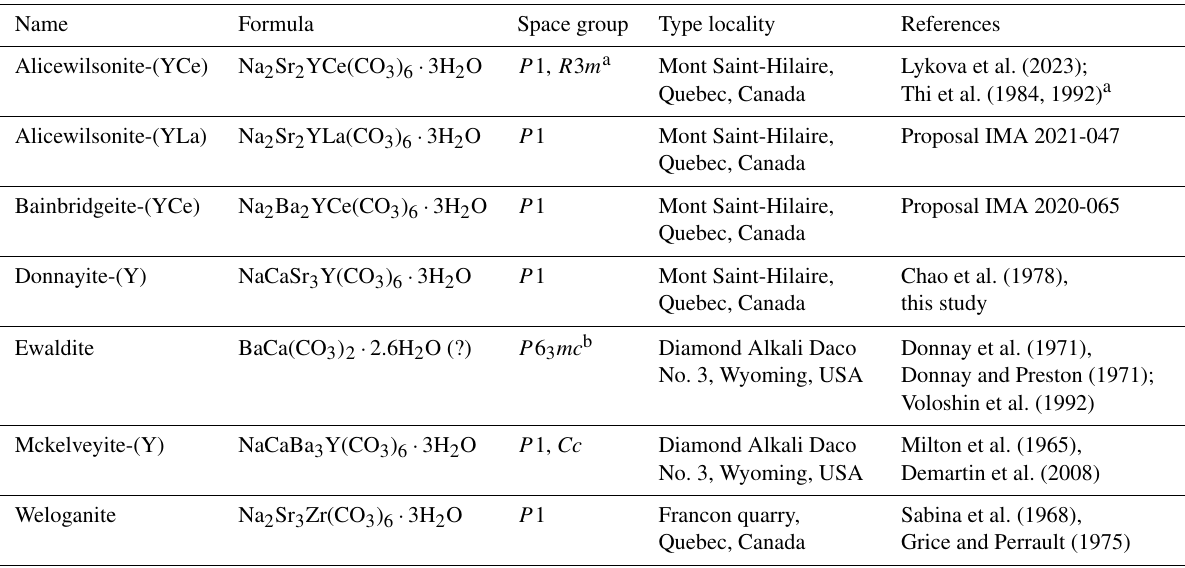
Table 8. Mckelveyite group